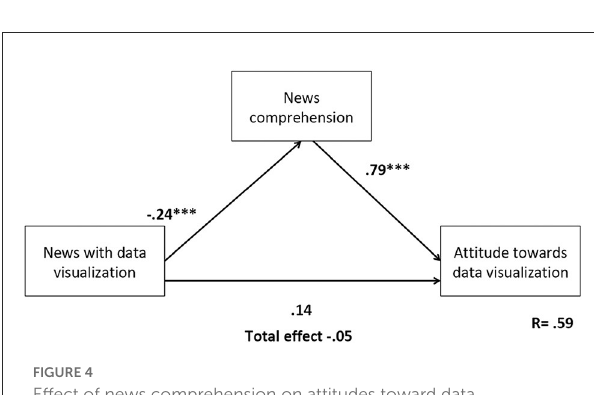
FIGURE4 Effect of news comprehension on attitudes toward data visualization. Model: independent variable—type of news; mediating variable—comprehension; dependent variable—attitudes toward data visualization. *** p <